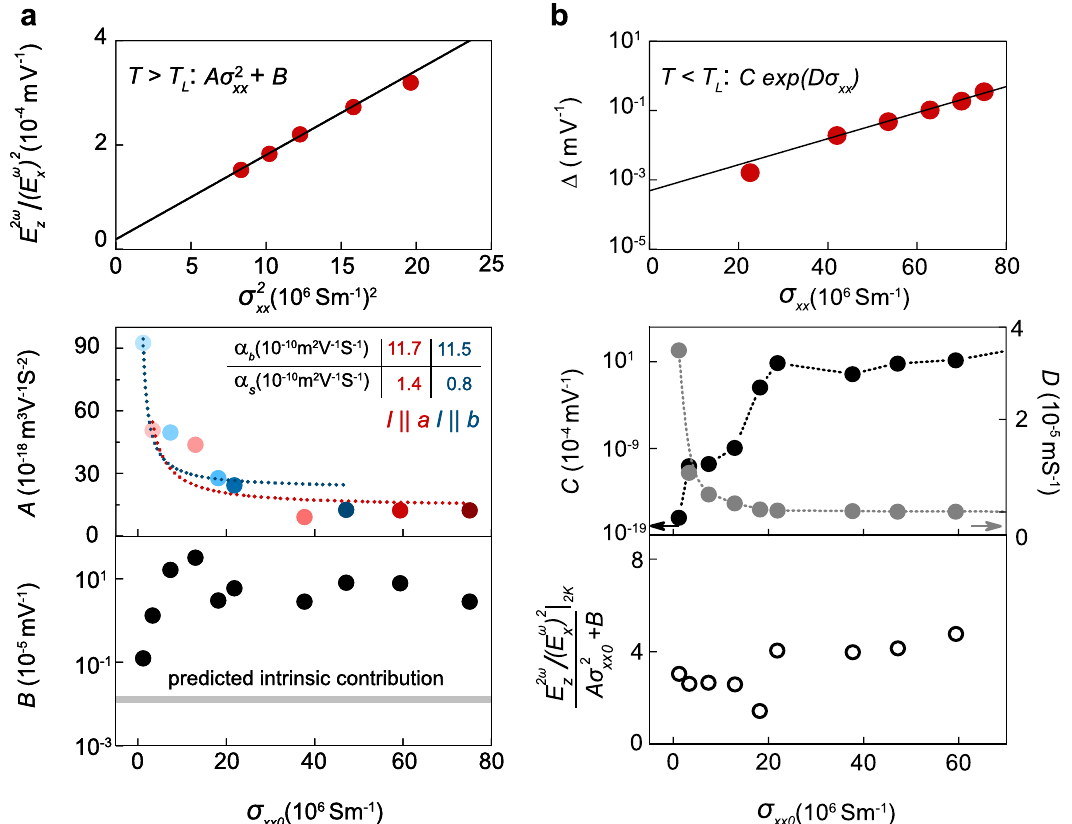
(cid:4) (cid:5) 2 ¼ A σ 2 þ B for T > T L for 127-nm-thick xx (cid:4) (cid:5) for T < T L for 127-nm- (cid:6) (cid:6) = ð A σ 2 þ B Þ vs. σ (cid:6) xx 0 xx 0 E ω x ð Þ 2 2 K